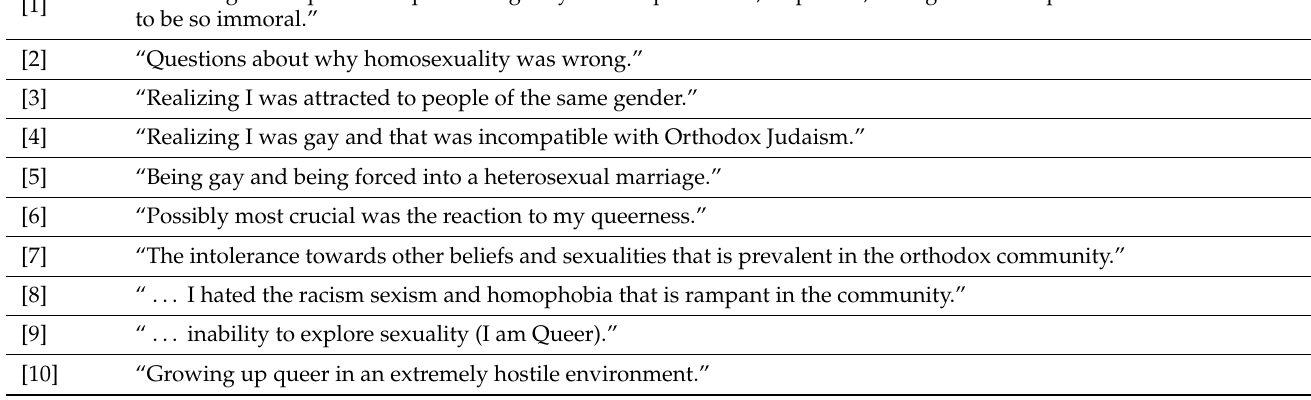
Table 1. Sample responses from LGBTQ+ individuals who attributed their sexual identity and/or religious views on homosexuality to their